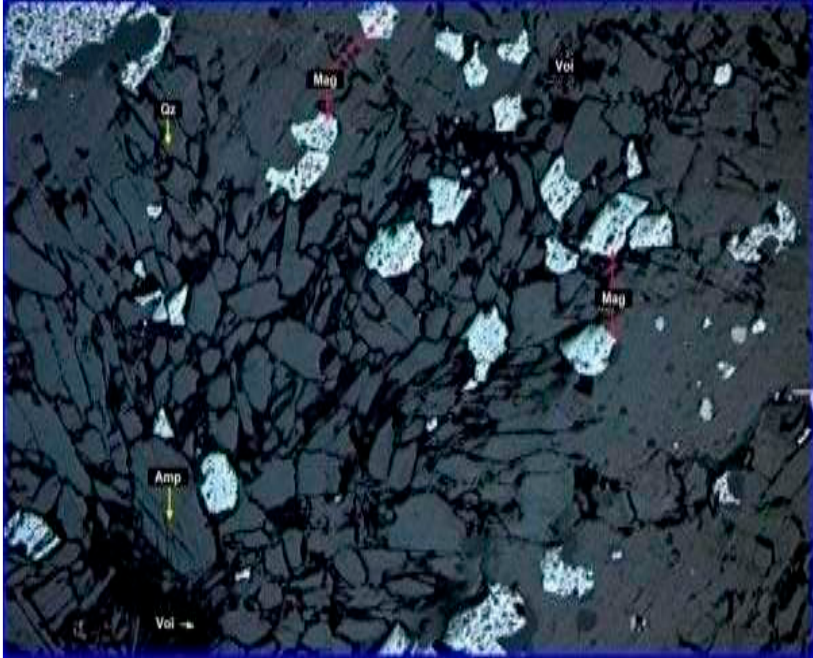
Figure 4. Association of amphibole with quartz and magnetite (×200).